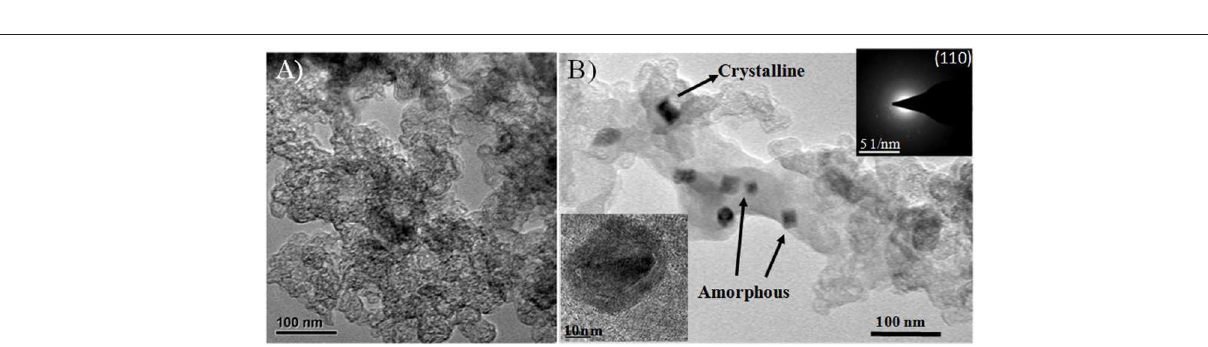
Frontiers in Chemistry |